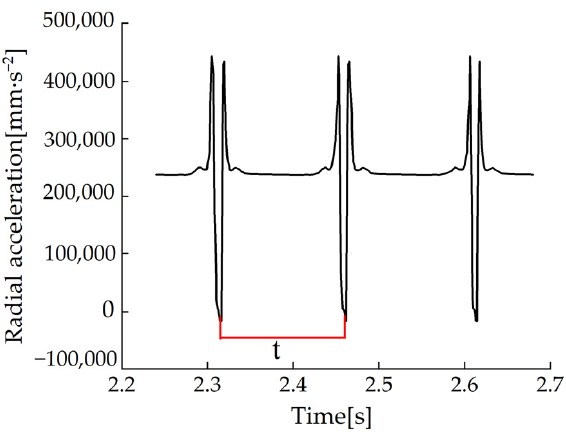
Figure 27. Lateral acceleration signal diagram of multiple periods.